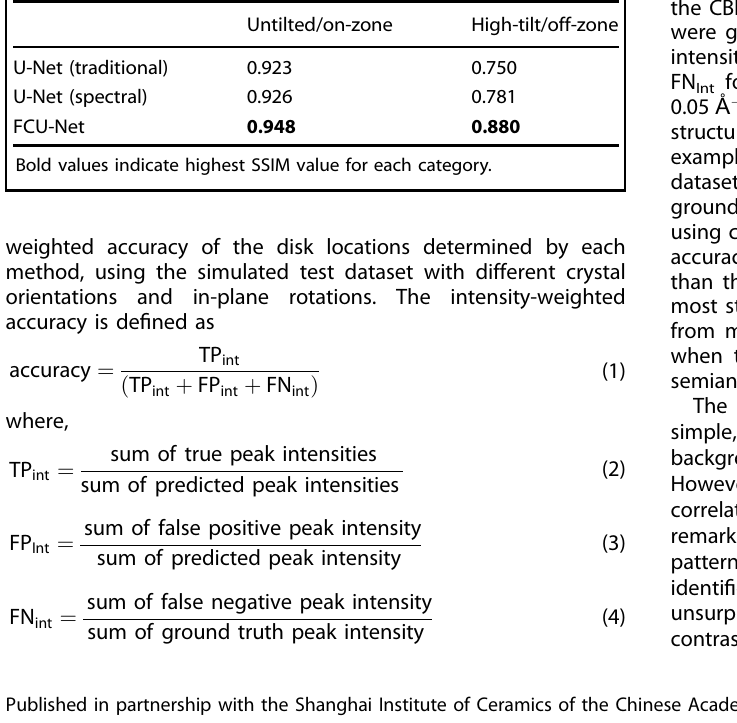
Fig. 1 Overview of the methods used in this paper. a Multislice diffraction simulations of many samples with different crystal structures, compositions, orientations, and thicknesses, using various microscope parameters. b Augmentation of the simulated images by applying elliptic distortion, pattern shift, limited signal-to-noise, and background functions. c Deep-learning training. d Experimental geometry for diffraction pattern measurements. e Dataset preprocessing. f Inversion of experimental diffraction images to predict the structure factors using the FCU-Net trained in c . Table 1. Accuracy of the recovered structure factor images evaluated using the SSIM on the test dataset.